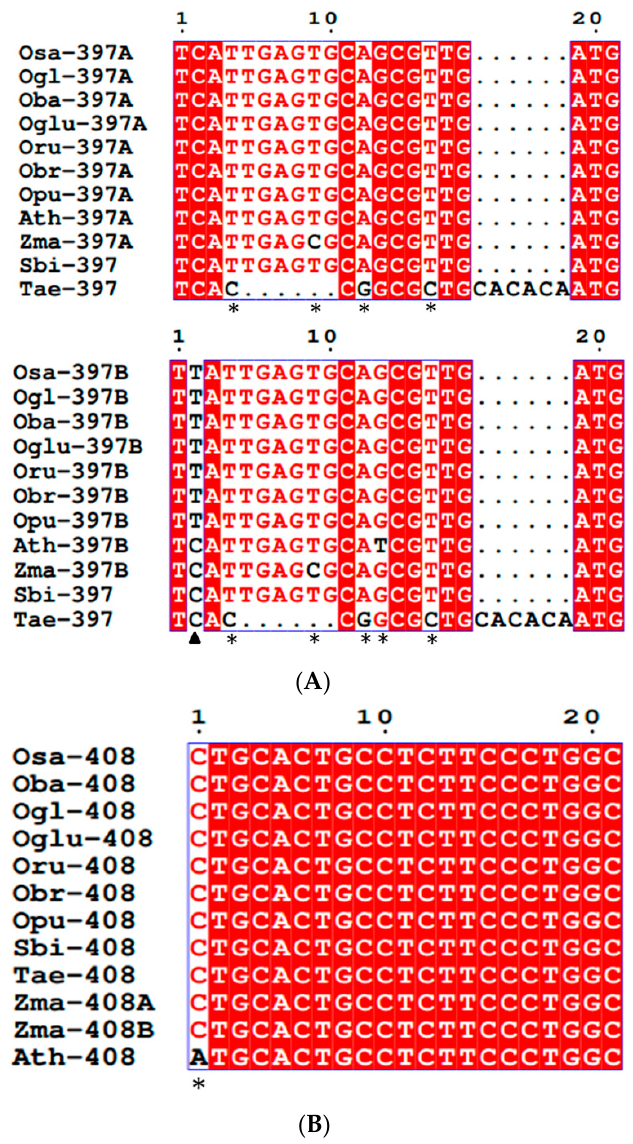
Figure 2. Multiple sequence alignment of mature MIR397 and MIR408 to detect the region of conservation and divergence. ( A ) Multiple sequence alignment of mature MIR397A showed that mature RNA of all poaceae members and Arabidopsis was highly conserved, except for Z. mays and T. aestivum . Similarly, multiple sequence alignment of mature MIR397A showed that mature RNA of all Oryza spp. was highly conserved. ( B ) Multiple sequence alignment of mature MIR408 showed that a genome-specific SNP was observed in Arabidopsis at the 1st position, where C was replaced with T. * denotes position of SNP. Osa— O. sativa ; Oba— O. barthii ; Ogl— O. glaberrima ; Oglu— O.